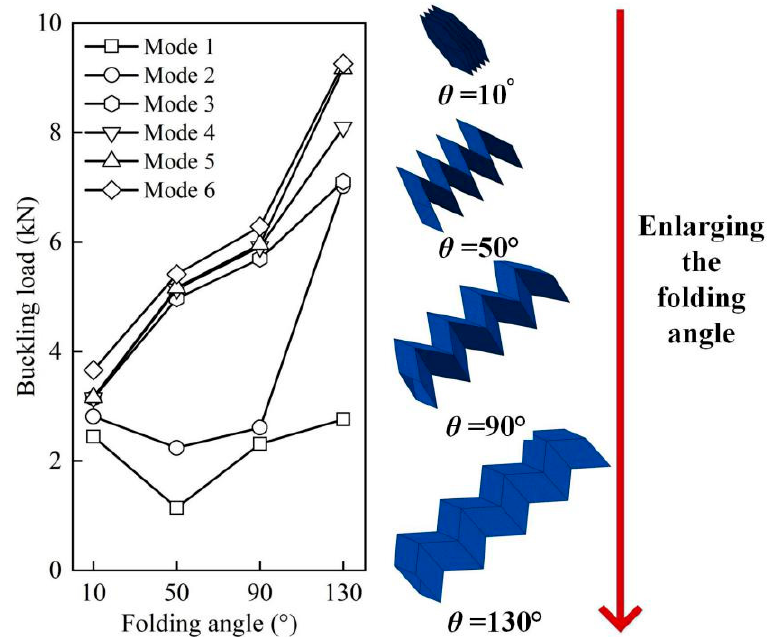
Figure 4. Comparison of the axial buckling loads between the theoretical prediction and numerical simulation for the composite plate.